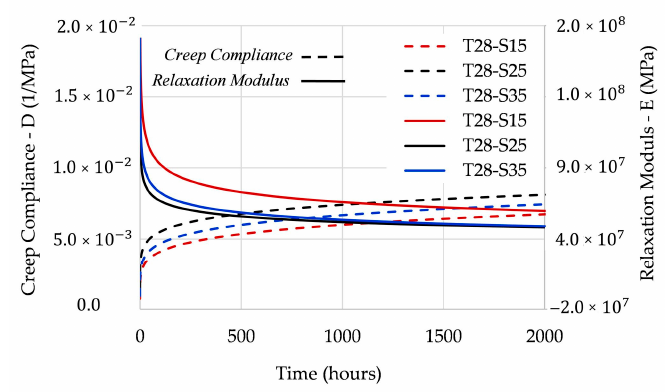
Figure 6. Relationship between the viscoelastic properties.